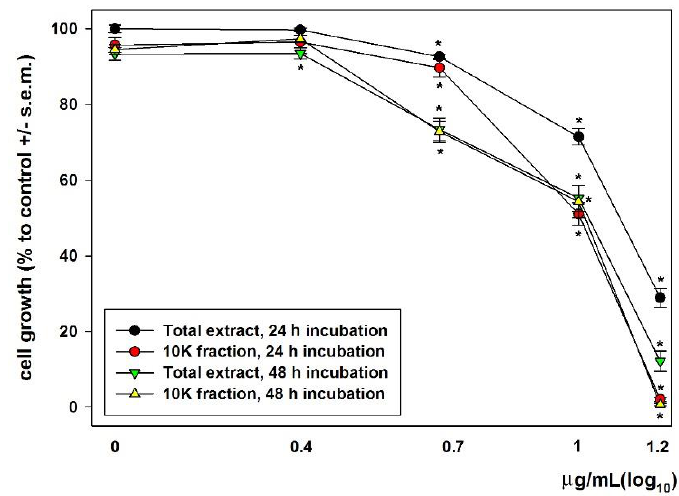
Figure 2. Dose response e ffect of total extracts and 10K fractions on the viability and growth of MDA-MB231 cells after either 24 or 48 h of exposure. Error bars correspond to the standard error of the mean (s.e.m.) of three independent measurements. * p < 0.05 .